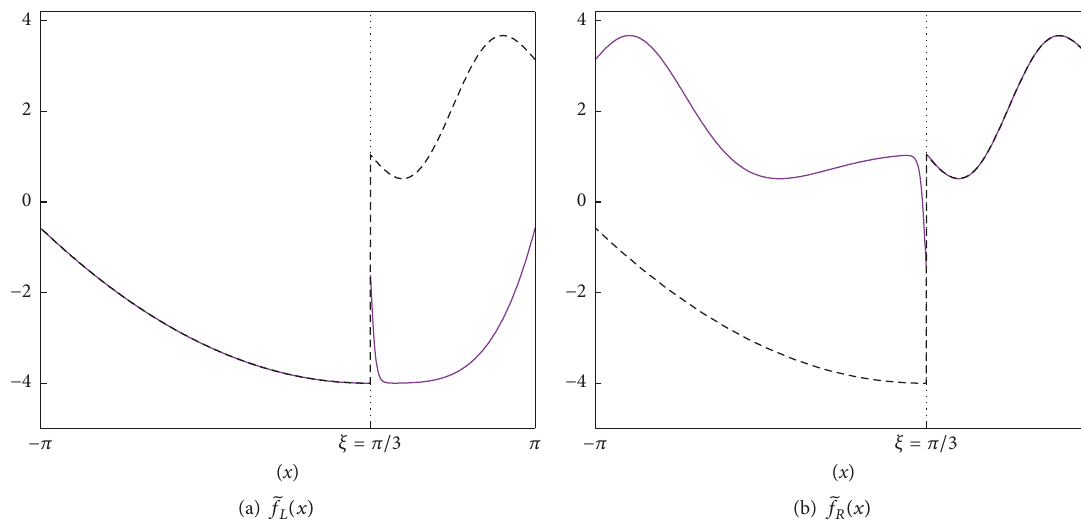
̃ 𝑓 (𝑥) and ̃ 𝑓 (𝑥) with 𝑚 = 40 for the test function 𝑓 𝐿 𝑅